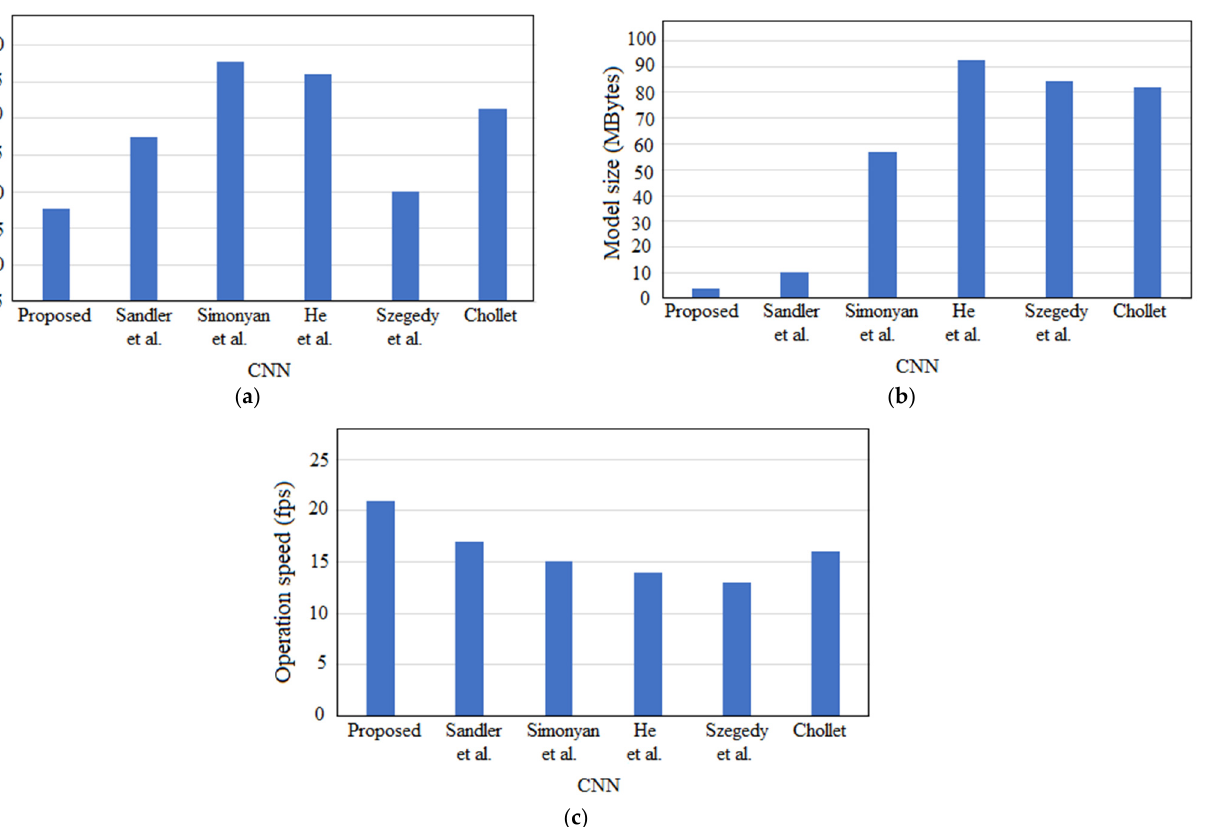
Figure 22. Performance comparison of proposed S-CNN with other off-the-shelf CNN structures proposed by Sandler et al. [27], Simonyan et. Al [28], He et al. [29], Szegedy etr al. [30] and Chollet [31] ( a ) Accuracy comparison, ( b ) model size, and ( c ) processing speed in frames per second.